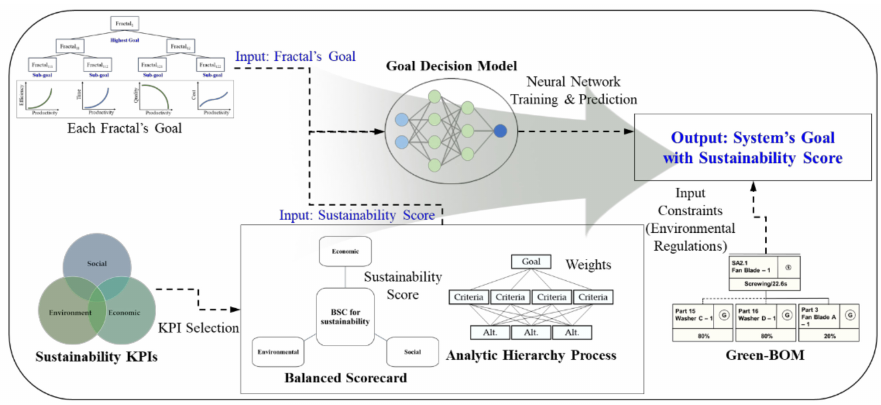
Figure 20. Flow of process reconfiguration and optimization by three methods.